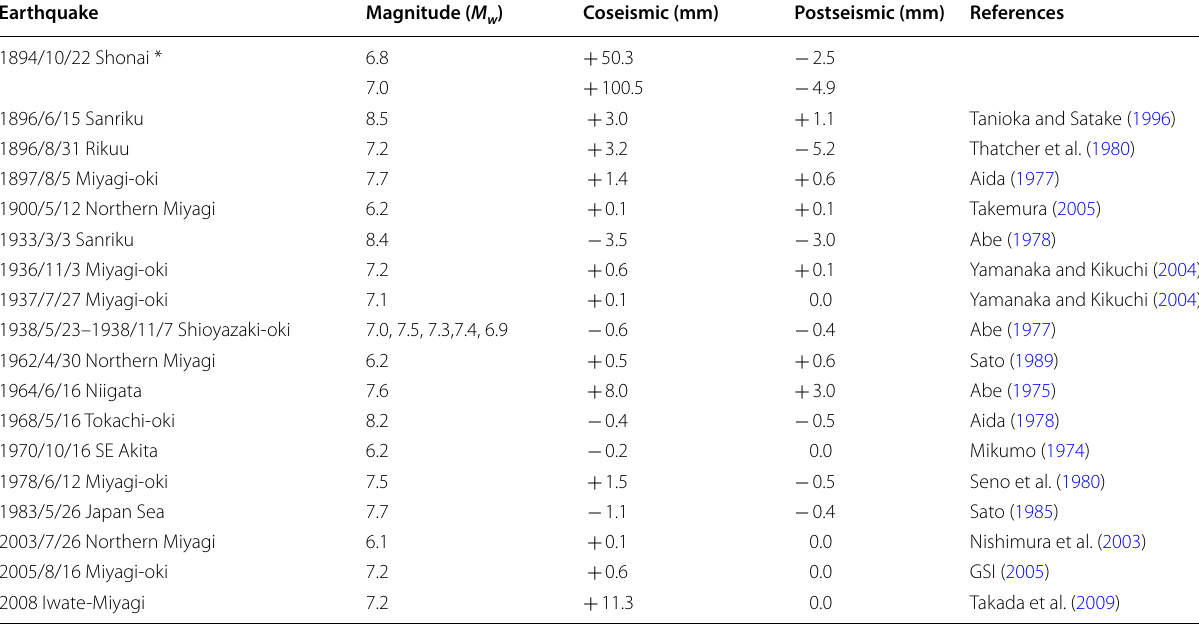
Postseismic changes are cumulative viscoelastic effects until 2012 *Fault parameters for the 1894 Shonai earthquake are assumed as 38.75ºN, 139.95ºE, D